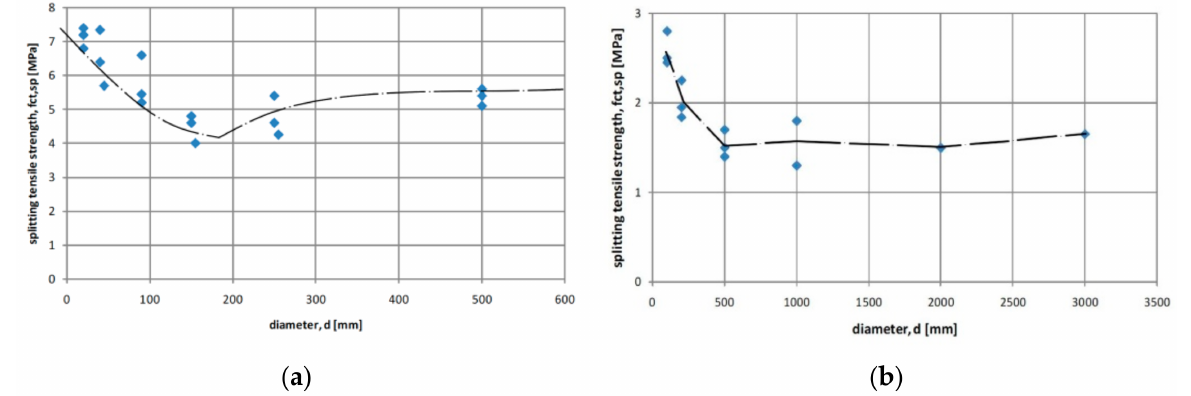
Figure 4. The influence of the cylinder’s diameter on splitting tensile strength. Test results based on Hasegawa et al. [26] ( a ) and based on Bažant et al. [27] ( b